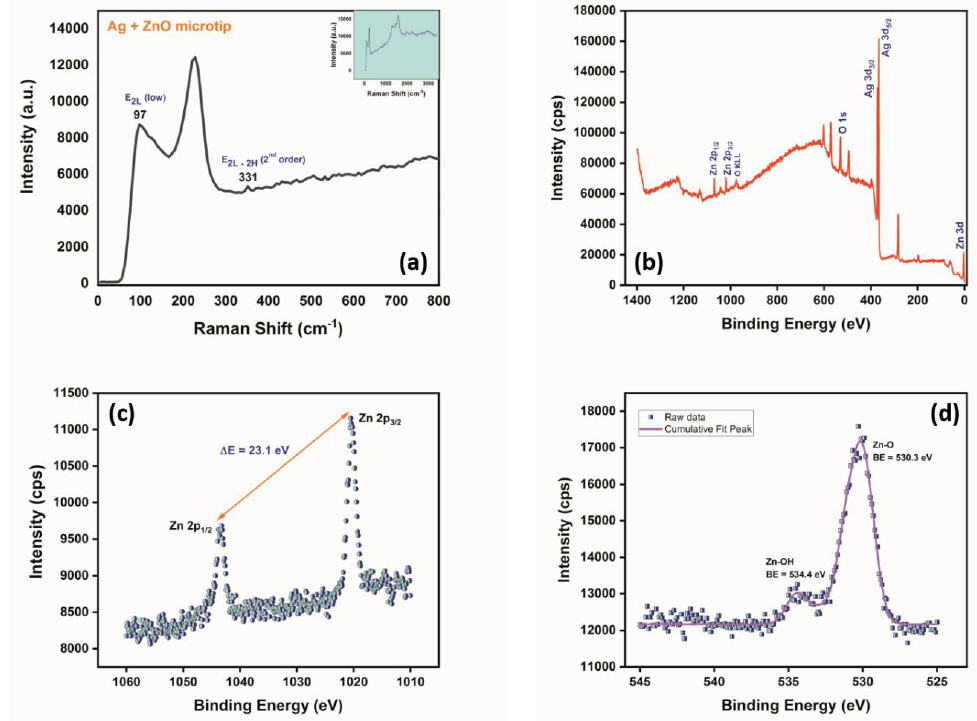
Figure 5. ( a ) Raman spectrum of ZnO grown over a Ag-sputtered micropipette tip between 0 – 800 cm −1 (entire spectrum shown in the inset). ( b ) Survey scan showing the presence of Zn, O, and Ag elements on the surface of the micropipette tip after sputtering and hydrothermal growth. ( c ) Zn 2 p spectrum revealing the spin orbit doublet of Zn2 p 1/2 and Zn 2 p 3/2 . ( d ) O 1 s spectra confirming the dominance of Zn-O bonding at the surface over Zn-OH.